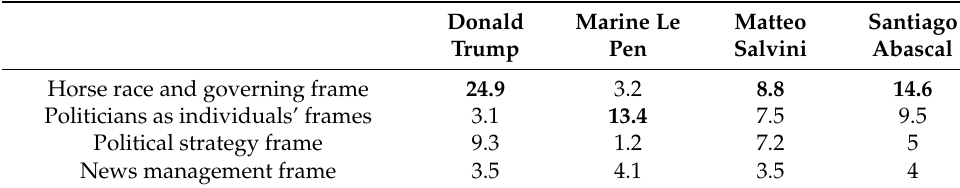
Table 2. Use of game frames on Twitter (%). Relevant findings are presented in